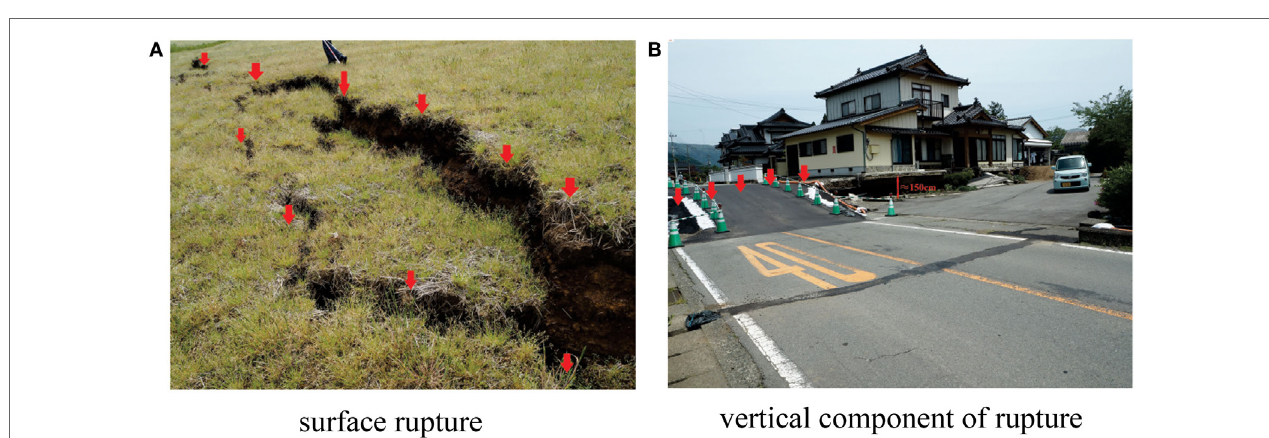
FigUre 2 | surface rupture of the 2016 Kumamoto earthquake (a) surface rupture (B) vertical component of rupture .